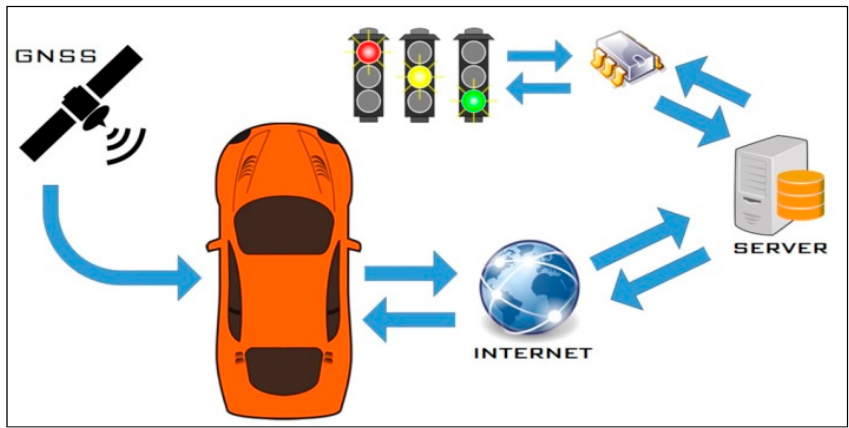
Figure 1. General structure of the proposed system.